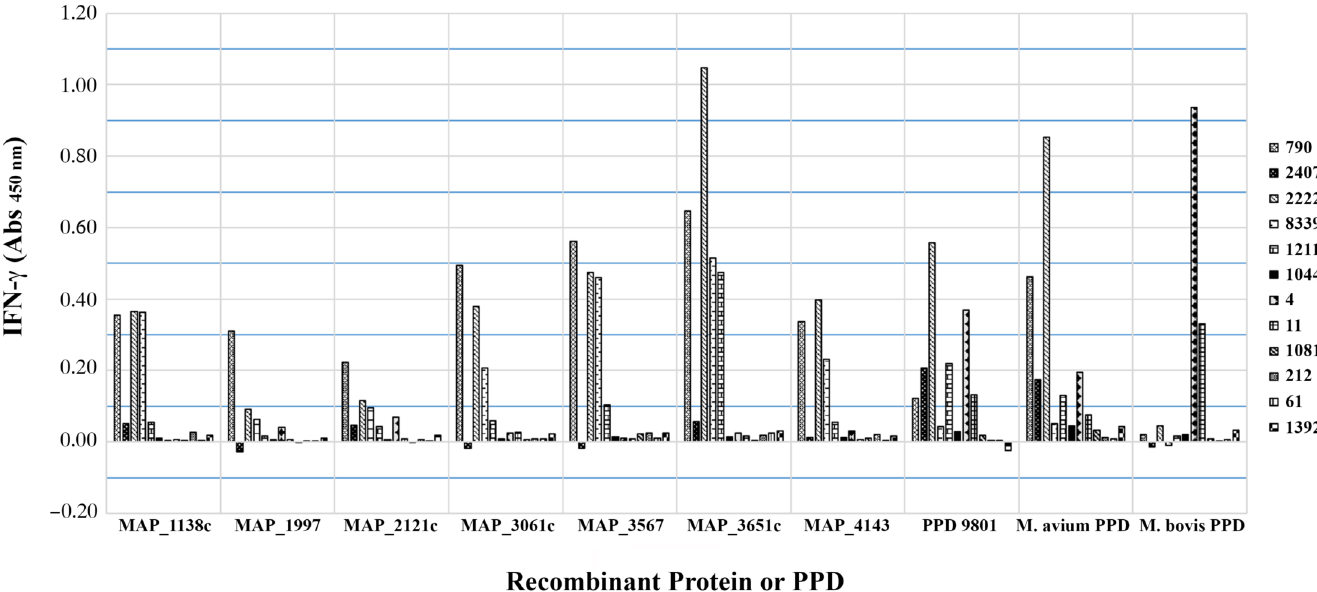
Fig 5. Secretion of IFN- γ using whole blood from Johne ’ s positive animals, M . bovis sensitized animals, and negative control animals. Whole blood was incubated with selected recombinant proteins and mycobacterial PPDs for 20 – 22 hrs as indicated in the materials and methods. Absorbance was measured at 450